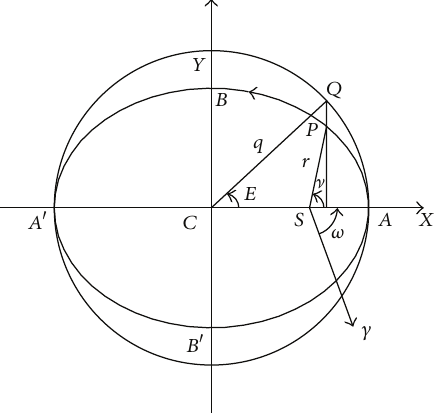
Figure 1: Size, shape, and anomalies in orbital plane 2-dimensional coordinate